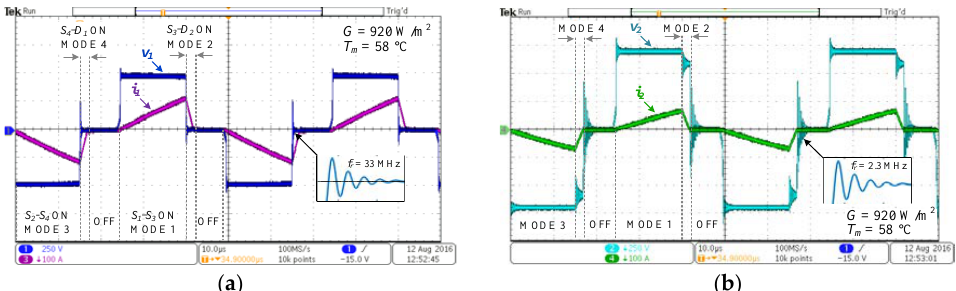
Figure 21. HF transformer voltage and current waveforms recorded by Tektronix MSO3034 oscilloscope, Tektronix P5205A high voltage differential probe and Rogowski CWTUM/3/B current probe ( f sw = 20